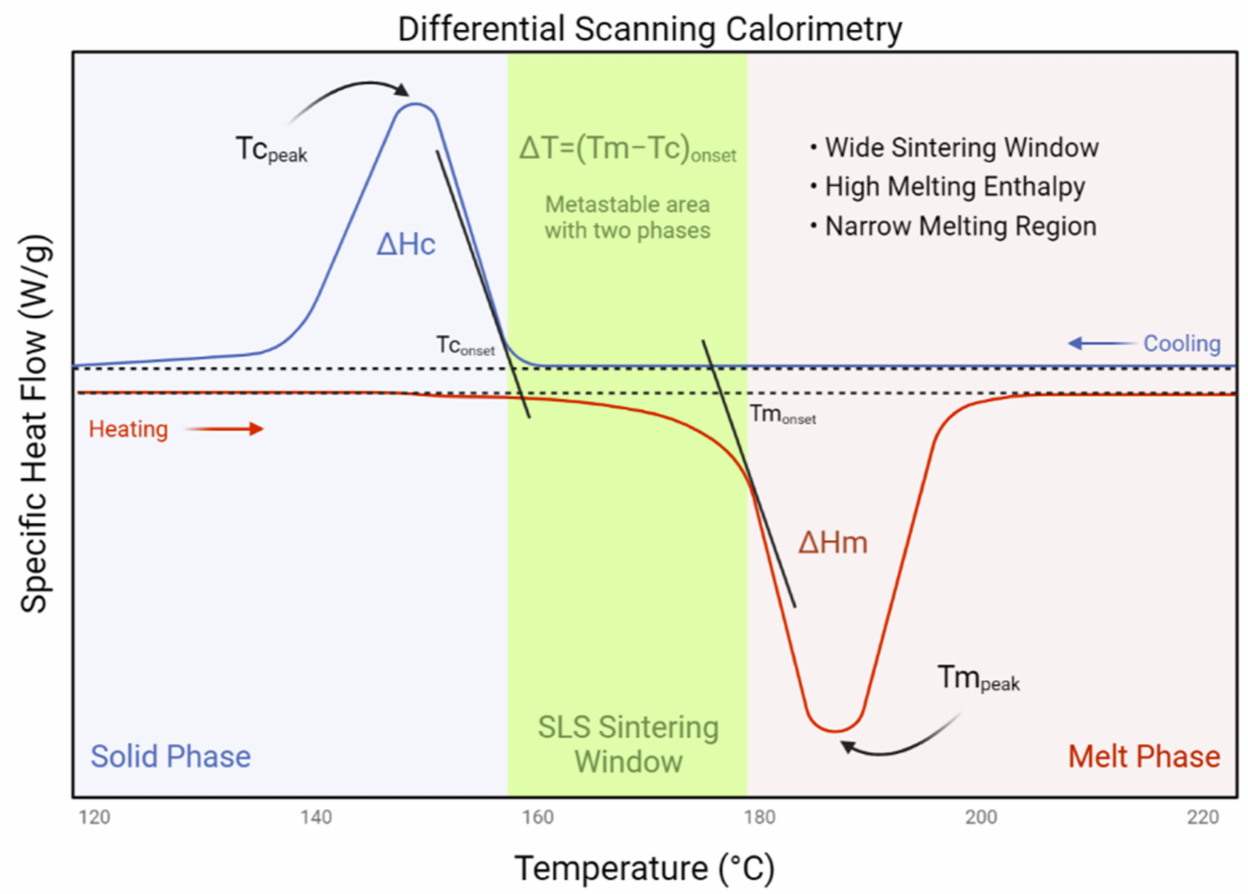
Figure 5. An ideal heat flow curve from differential scanning calorimetry analysis in the context of SLS printing, including a melt phase and solid phase determined from a typical heating and cooling rate of 10 ◦ C/min. Adapted from